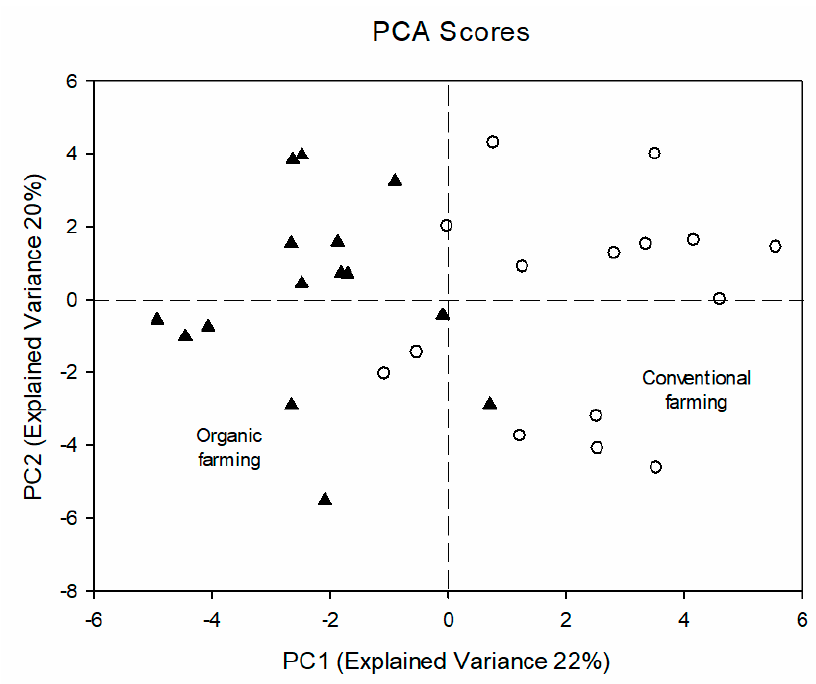
Figure 1. PCA score plot analysis (PC1 vs. PC2) of Brassica oleracea (var. italica ) samples. Conventional samples are indicated by white circle and organic sample are indicated by black triangles (for the abbreviation used see Table S1). Foods 2020 , 9 , x FOR PEER REVIEW